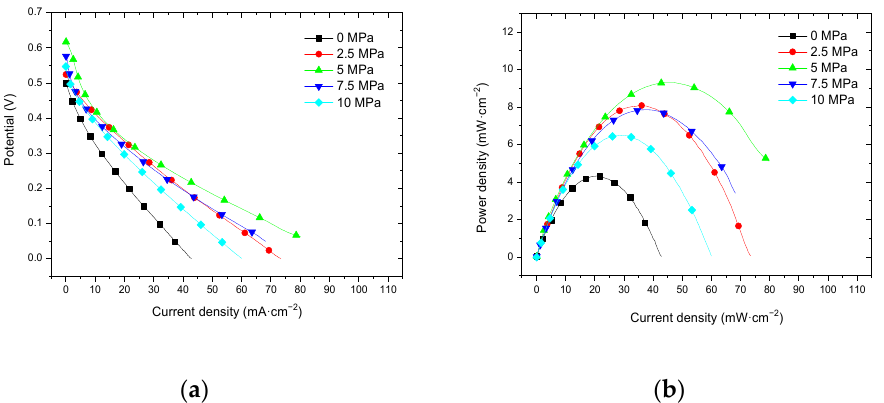
Figure 11. The effect of hot-pressing pressure on the performance of titanium mesh-based MEA at 60 °C with air self-breathing environment. ( a ) Curve between current density and voltage; ( b ) curve between current density and power density.